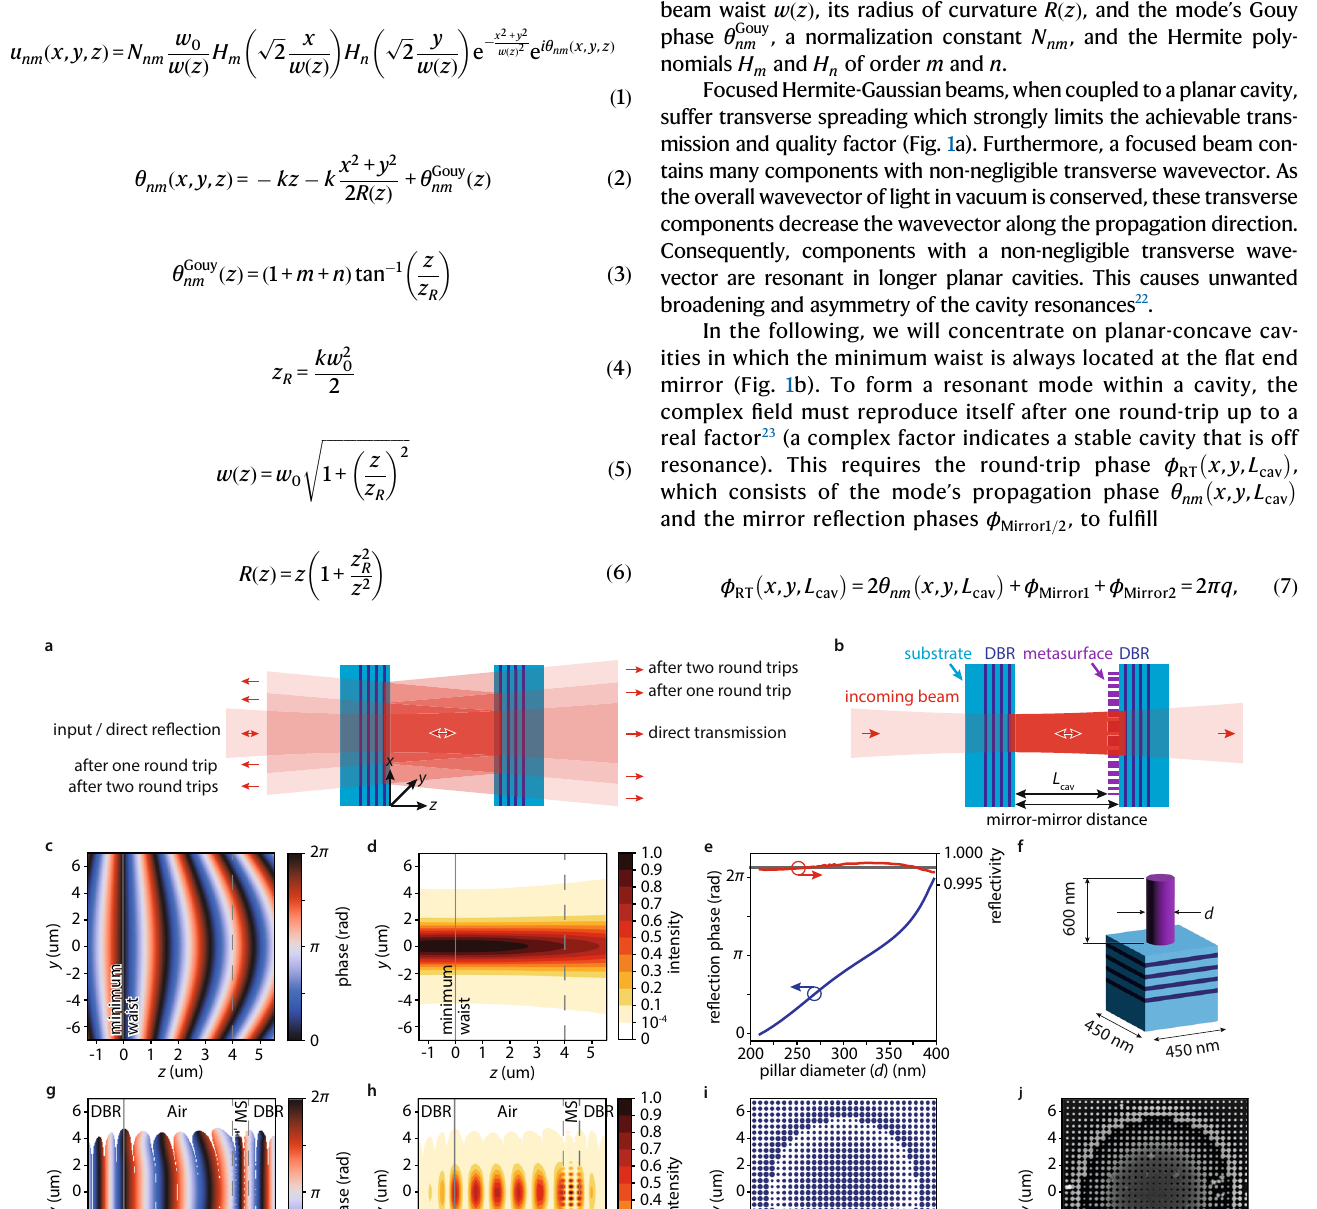
curvatureof20um. d intensityevolution(false-colorplot)of the Gaussianbeamin panel ( c ). e metasurface nanopillar library. Simulated diameter ( d ) dependent re fl ection phase (blue line) and re fl ectivity (red line) of Silicon nanopillars on a Silica/Titania DBR. As a reference, the grey line shows the re fl ectivity of a DBR consisting of 7 Silica/Titania layer pairs without metasurface. f metasurface nano- pillardimensions and unitcell. Light blue: Silica, dark blue: Titania, purple: Silicon. g fi